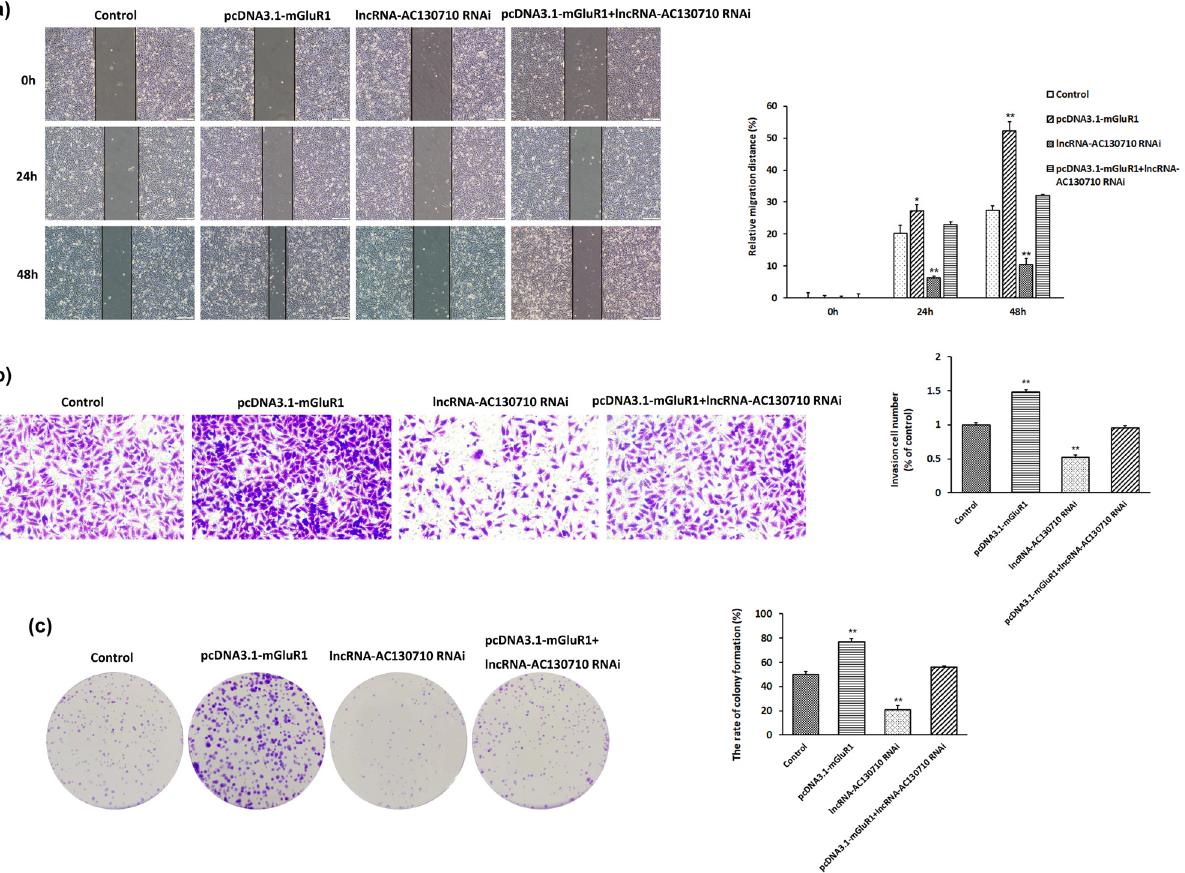
Figure 5: E ff ects of modulating lncRNA - AC130710 and mGluR1 expression on the migration, invasion and clonal formation of A375 cells. ( a ) Cell migration was investigated by wound healing scratch assay in A375 cells transfected with pcDNA3.1 - mGluR1 and lncRNA - AC130710 siRNA vectors. ( b ) Cell invasion was investigated in A375 cells transfected with pcDNA3.1 - mGluR1 and lncRNA - AC130710 siRNA vectors. ( c ) Colony formation of A375 cells transfected with pcDNA3.1 - mGluR1 and lncRNA - AC130710 siRNA vectors. Data are presented as means ± SD ( n = 3; * p < 0.05, ** p < 0.01 )